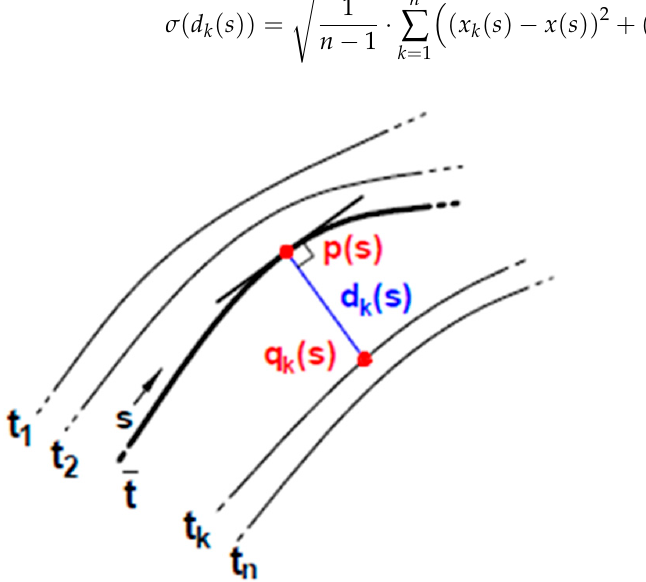
Figure 2. Observed trajectories ( t 1 ,t 2 , . . . , t n ) of an agent and related average trajectory t .